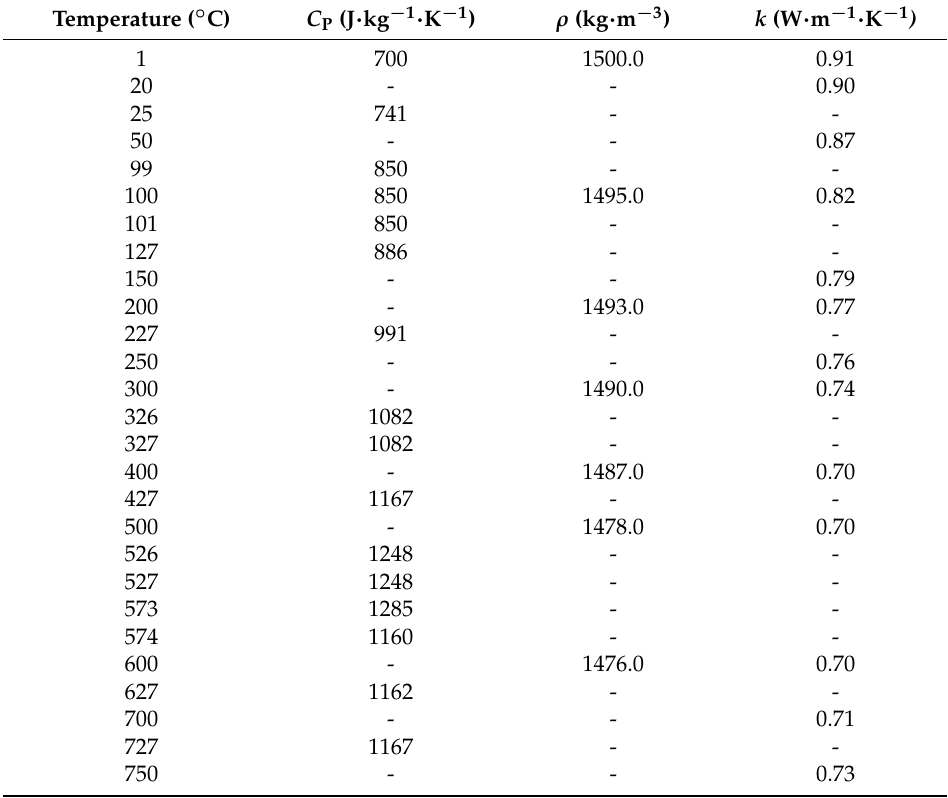
Table A2. Material properties for the mold in the numerical